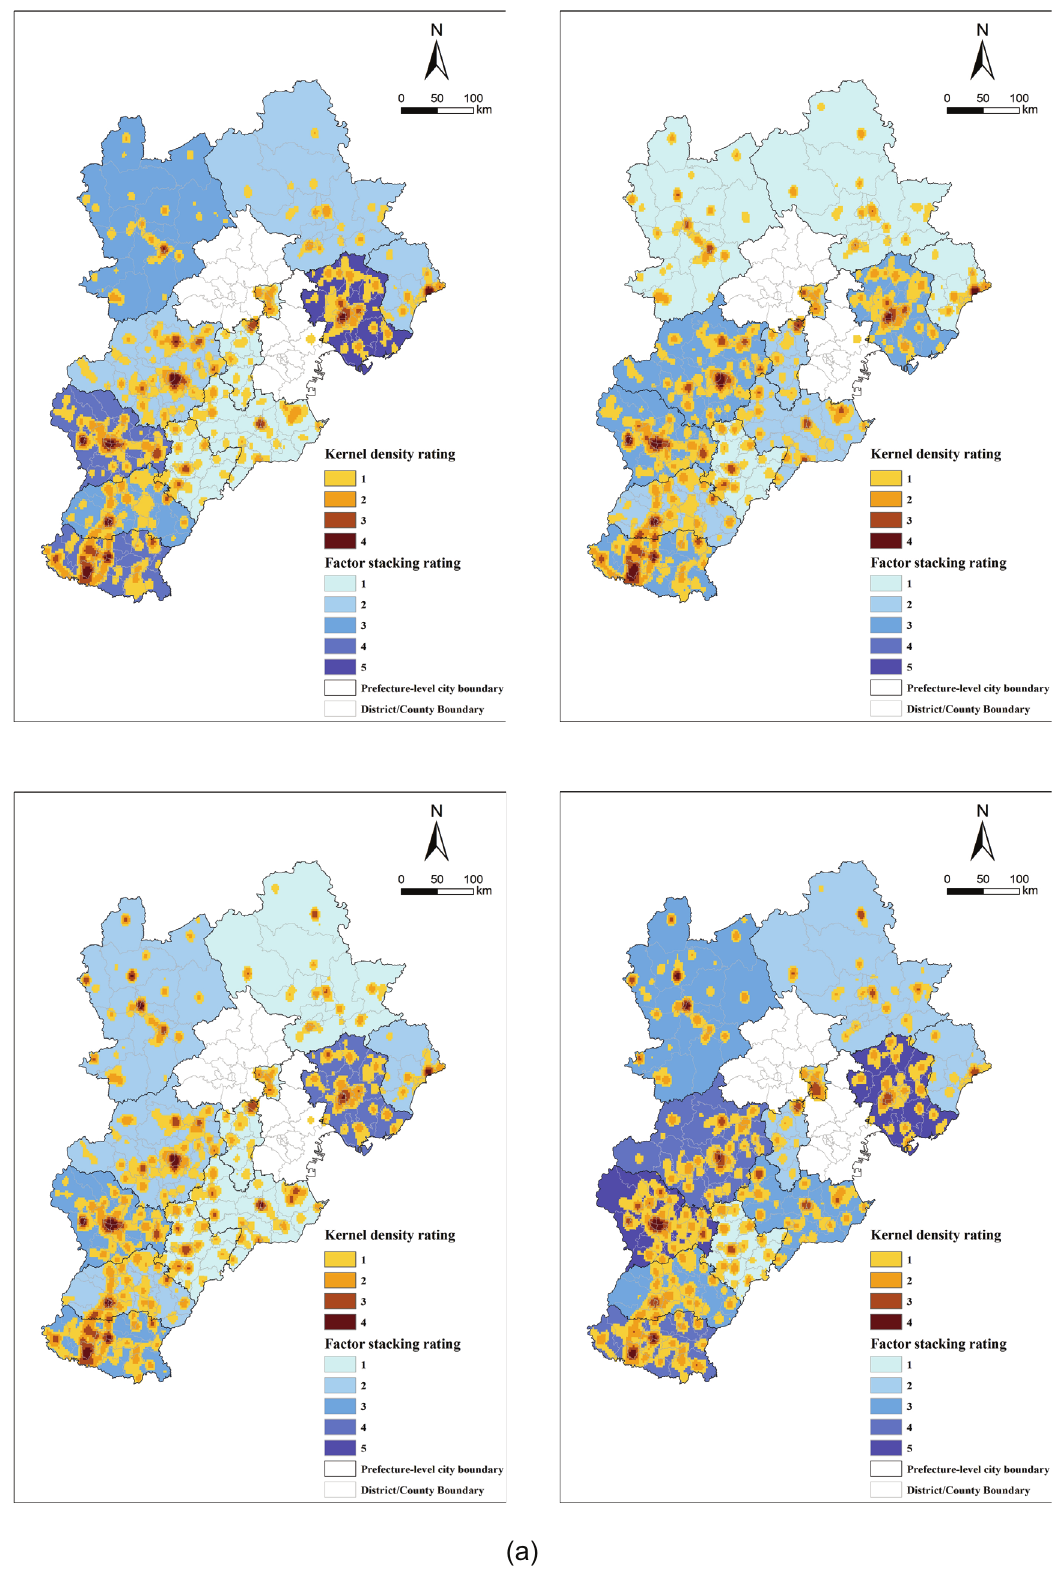
Fig. 3. Spatial differentiation diagram of in fl uencing factors in 2005/2010/2015/2020. (a) Traditional energy industry in 2005/2010/ 2015/2020. (b) Renewable energy industry in